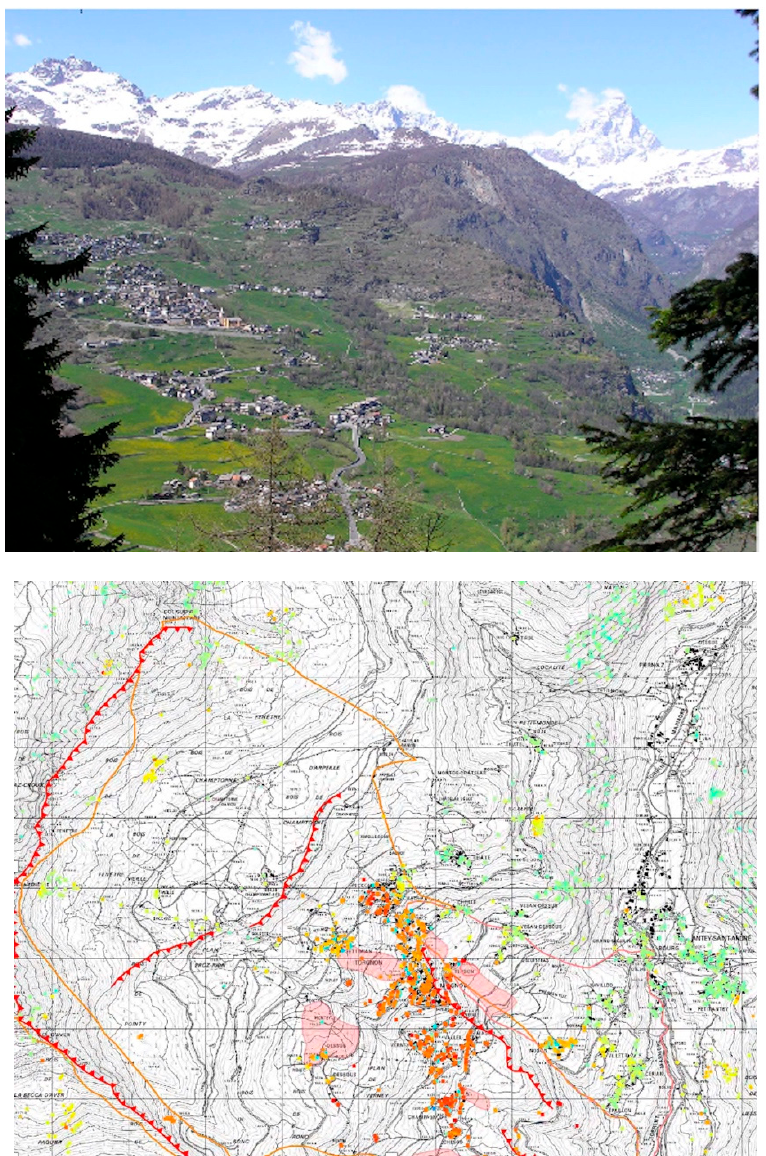
Figure 8. The deep debris flow in Torgnon.